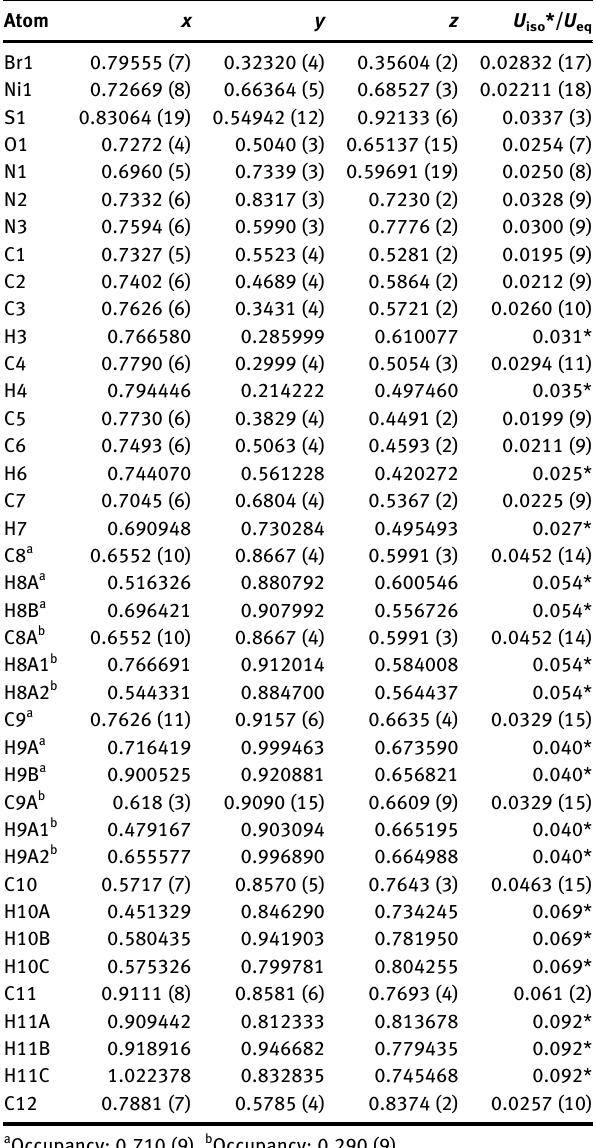
Table  : Fractional atomic coordinates and isotropic or equivalent isotropic displacement parameters (Å  ).